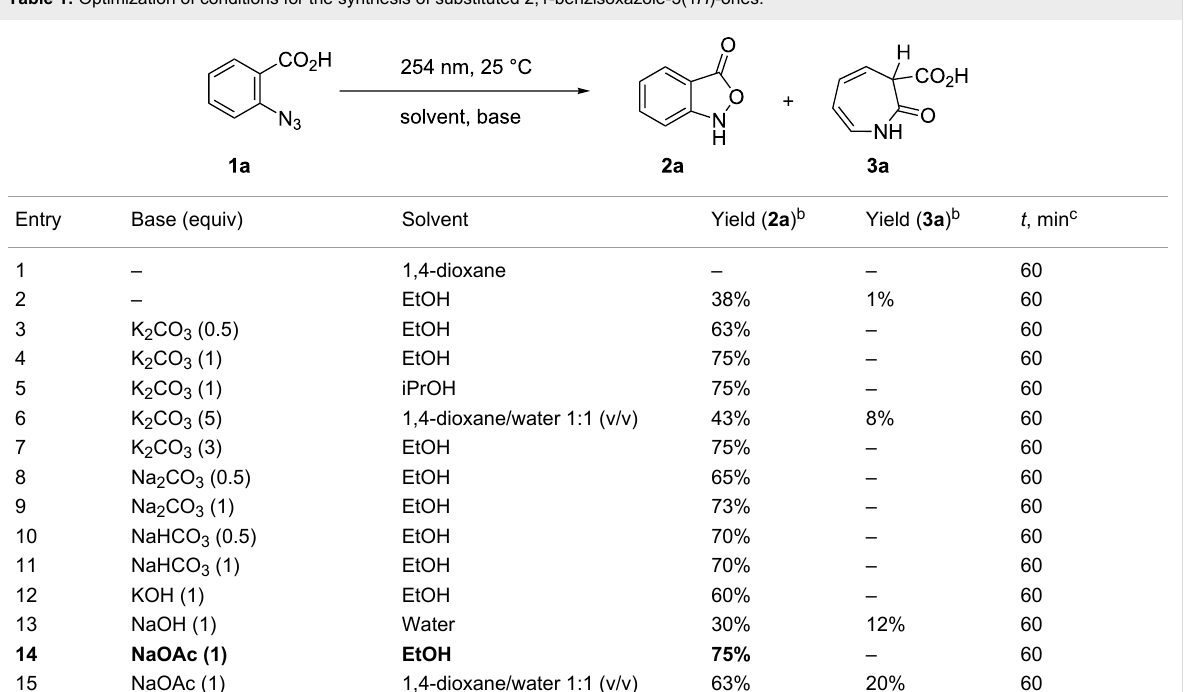
Table 1: Optimization of conditions for the synthesis of substituted 2,1-benzisoxazole-3(1 H )-ones. a